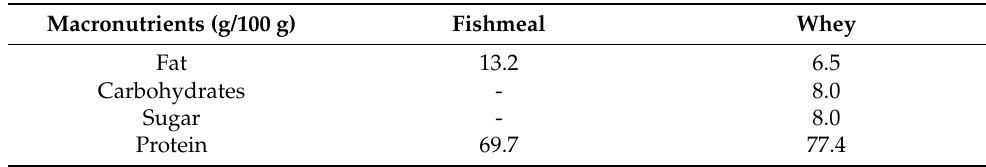
Table 1. Macronutrient content of the fishmeal and whey.